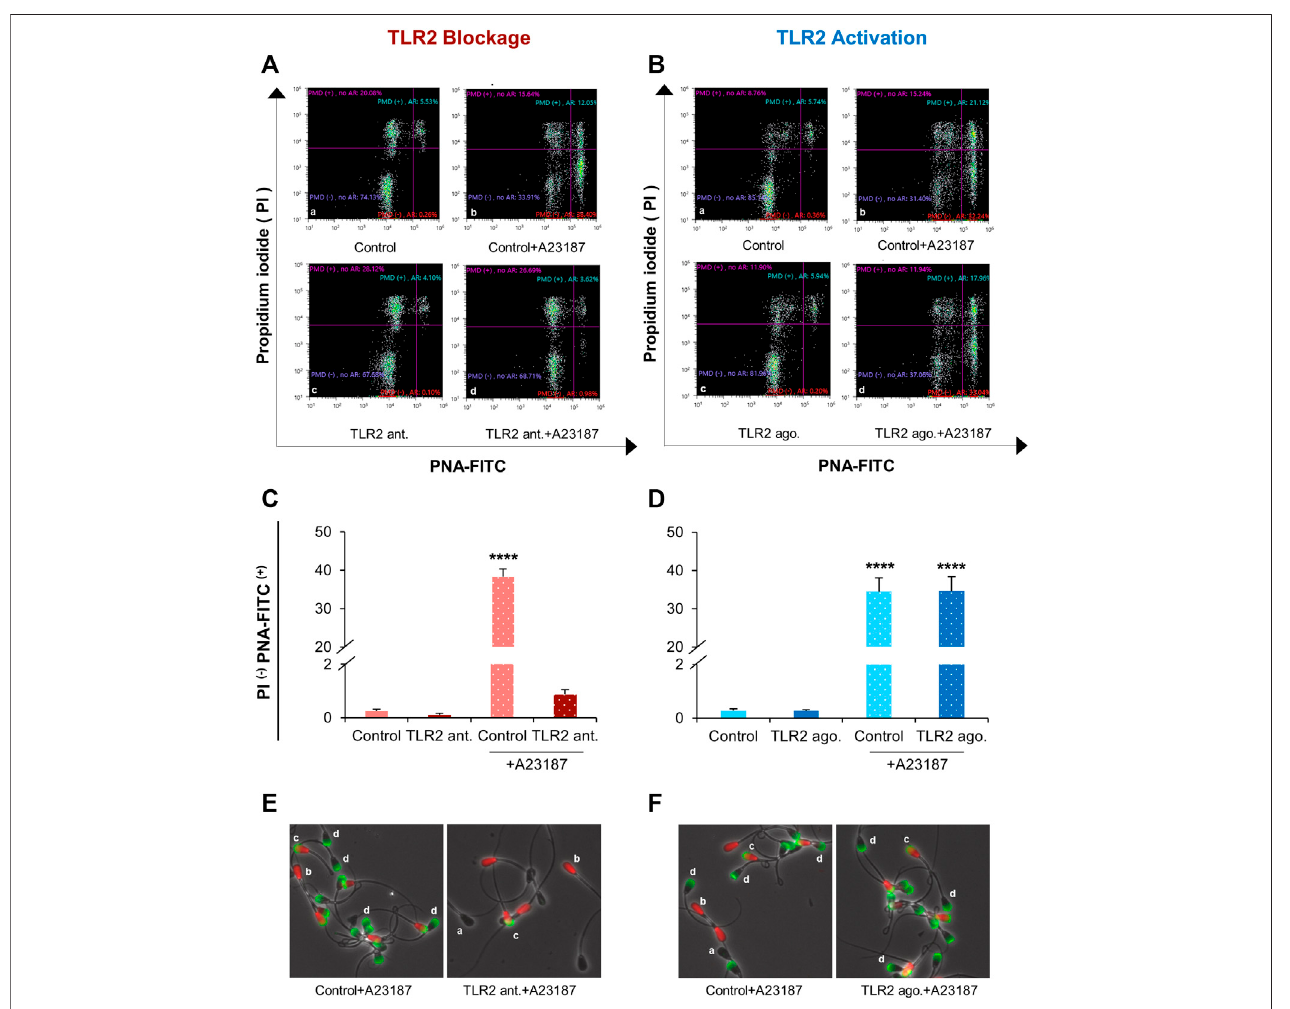
FIGURE 6 | Effect of TLR2 antagonist and agonist treatment on sperm acrosome reaction (AR) triggered by A23187 . Swim-up sperm were pre-treated by TLR2 antagonist (100 µM) or TLR2 agonist (100 ng ml − 1 ) for 30 min, washed, and triggered with or without 1 µM A23187 for 60 min. Then sperm were incubated with fl uorescein peanut agglutinin FITC-conjugate (PNA-FITC; for detection of induction of acrosome reaction (AR)) and propidium iodide (PI; for detection of plasma membrane damage (PMD)) for 8 min at 38.5 ° C in dark. The percent of live and acrosome-reacted sperm was analyzed by fl uorescence microscopy and fl ow cytometry. Untreated sperm were kept as a negative control (A) Representative dot plot diagram; a: Control; c: 100 μ M TLR2 antagonist; b: Control +1 μ M A23187; d: 100 μ M TLR2 antagonist +1 μ M A23187 and (C) Analysis of PNA-FITC and PI staining of bovine sperm in different treatment groups by fl ow cytometry (B) Representative dot plot diagram; a: Control; c: 100 ng ml − 1 TLR2 agonist; b: Control +1 μ M A23187; d: 100 ng ml − 1 TLR2 agonist +1 μ M A23187 and (D) Analysis of PNA-FITC and PI staining of bovine sperm in different treatment groups by fl ow cytometry (E) Representative images of TLR2 antagonist-treated sperm or (F) TLR2 agonist-treated sperm stained with FITC-PNA and PI viewed with fl uorescence microscope (200×). a: live intact acrosome, b: dead intact acrosome, c: dead reacted acrosome, d: live reacted acrosome. Data reported as means ± S.E.M of fi ve independent experiments. Asterisks denote a signi fi cant variance **** ( p < 0.0001) between the different groups compared to